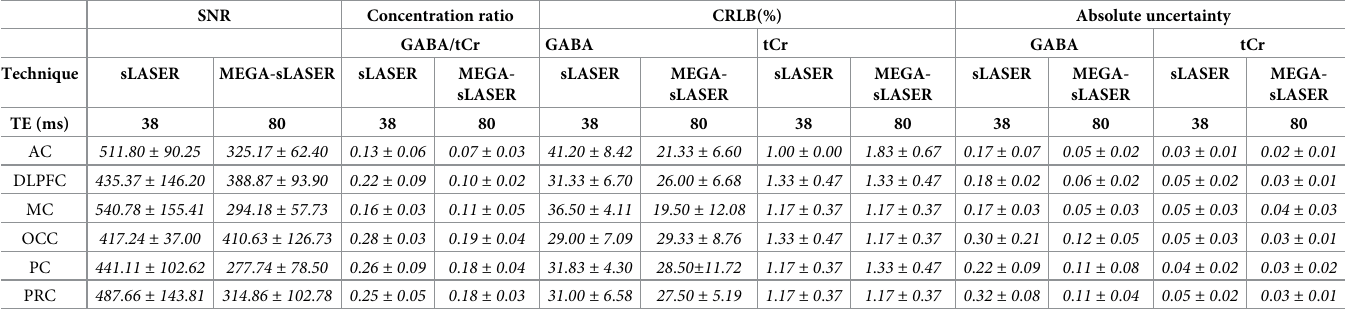
Table 1. Averaged SNR and LCModel results from six brain regions by the semi-LASER (sLASER) and the MEGA-sLASER approaches.